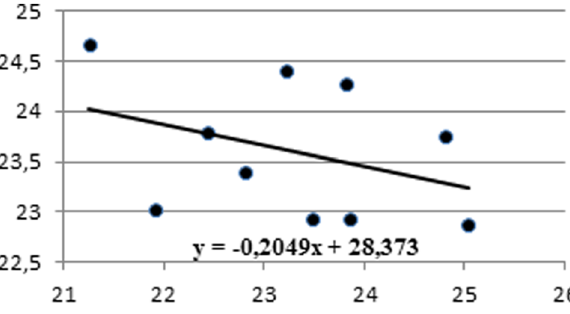
Figure 10: Linear approximation of the dependence of meat content on pre - slaughter weight in the pelvic - femoral third of